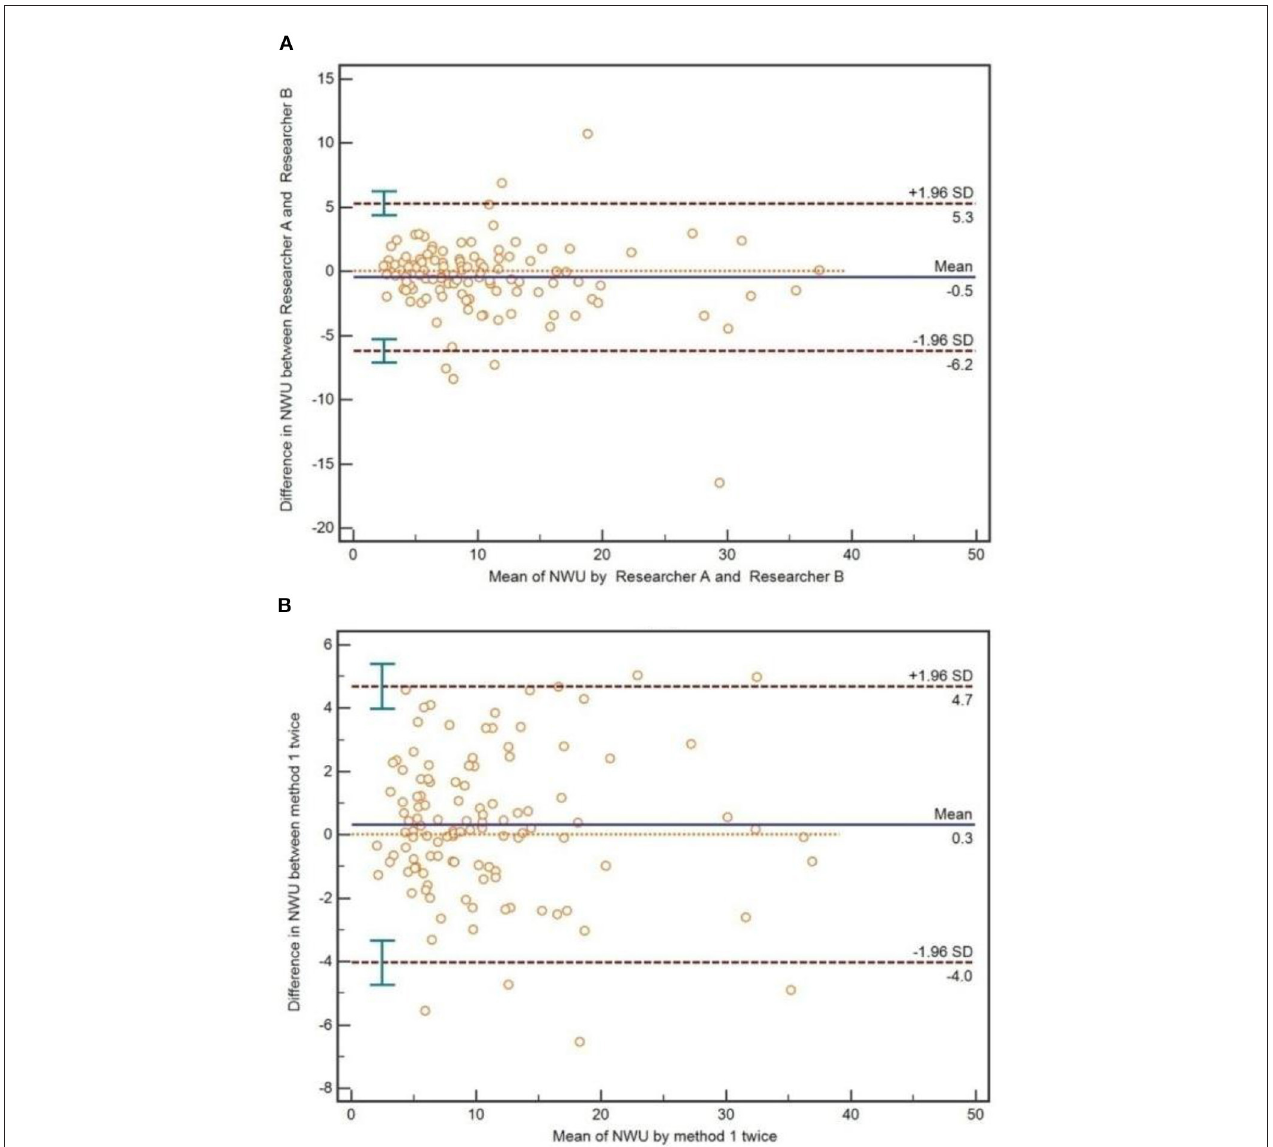
FIGURE 6 | Inter-reader and interoperation agreement for image patch-based net water uptake (IP-NWU). (A) The inter-reader agreement, evaluated by the Bland-Altman method; (B) The interoperation agreement, evaluated by the Bland-Altman method.